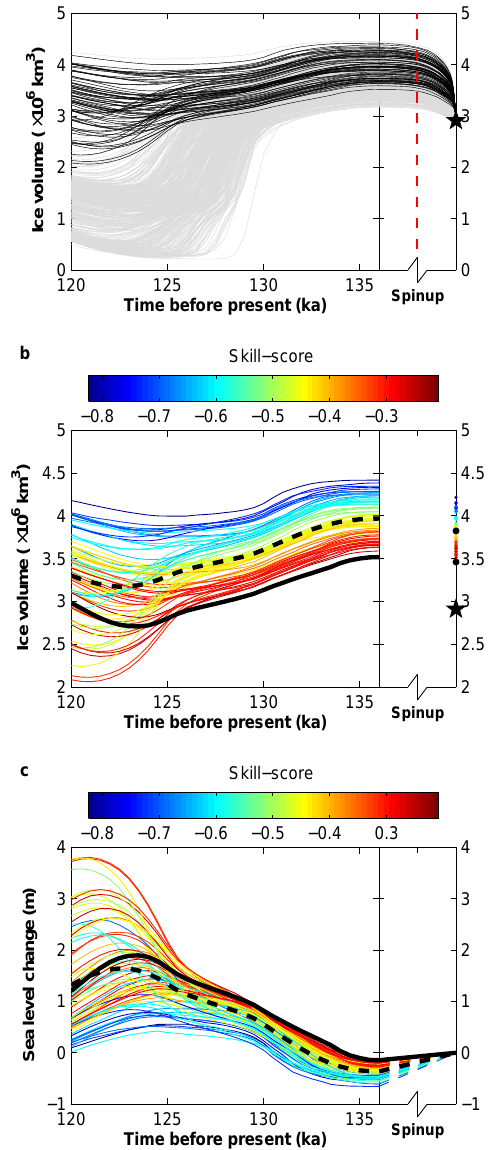
Fig. 6. Simulated LIG GrIS evolution from the ensemble of ice model simulations. (a) GrIS volume evolution for all 500 con- figurations. Black lines show experiments where ice persisted at NGRIP and Summit ice core locations. Also shown is the modern- day spin-up of 50000yr followed by a further 50000-yr spin-up with a 136-ka climatology (separated by red dashed line). (b) Ice volume change for 73 selected simulations according to constraints at the Summit and NGRIP cores. (c) Change in GrIS sea level con- tribution relative to present day for the selected simulations. Also shown in (b) and (c) is the skill-score for the simulated modern- day GrIS (see Eq. 7) with the simulated modern-day ice volume also shown on the right-hand axis of (b) . The star represents the modern-day observed GrIS volume (Bamber et al., 2001). The solid black line represents the simulation with the highest skill-score for the modern-day GrIS. The dashed black line represents the average for all accepted simulations.